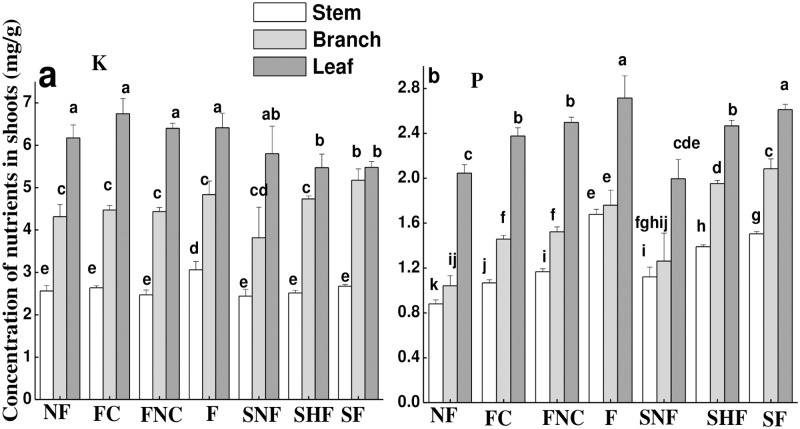
The concentrations of K (a) and P (b) in shoots of different parts under different treatments.Different letters indicate significant treatment effects between the means at p<0.05 analyzed by post hoc Tukey’s HSD test (means ± SE, n = 8).